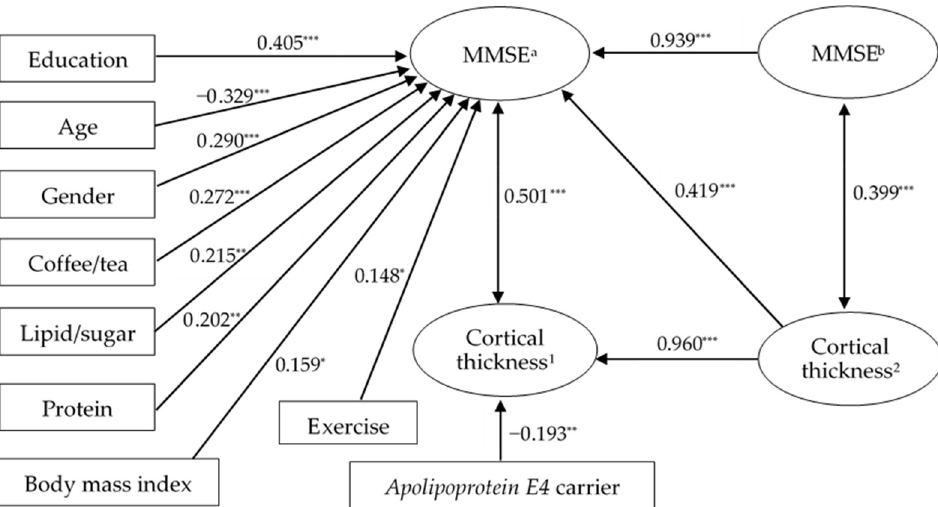
Figure 1. The correlation coefficients of demographic variables, three dietary patterns and MMSE. MMSE positively correlates with education, gender, 3DPs and exercise, except for age. Cortical thickness has an inverse correlation with APOE4 but a high correlation with MMSE. However, MMSE and cortical thickness have a pair-wise high correlation. Cortical thickness represents composite scores of hippocampus, amygdala and nucleus accumbens. Cortical thickness 1 : Time point corresponds to dietary pattern data collection; Cortical thickness 2 : available historical data with the closest time point with cortical thickness 1 . MMSE a : time point corresponds to dietary pattern data collection, MMSE b : one year prior to MMSE a ; *: p- value < 0.05; **: p- value < 0.01; ***: p- value < 0.001. MMSE, Mini-mental state examination. 2.330 Patients living with a spouse ( n = 153, AIC = 999.7) (Constant)